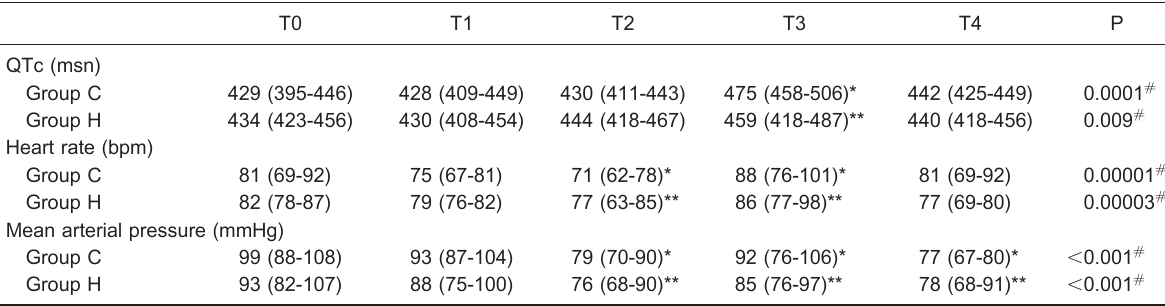
Table 2. Corrected QT intervals (QTc), heart rate and mean arterial pressure at various times in groups C (n=25) and H (n=25).